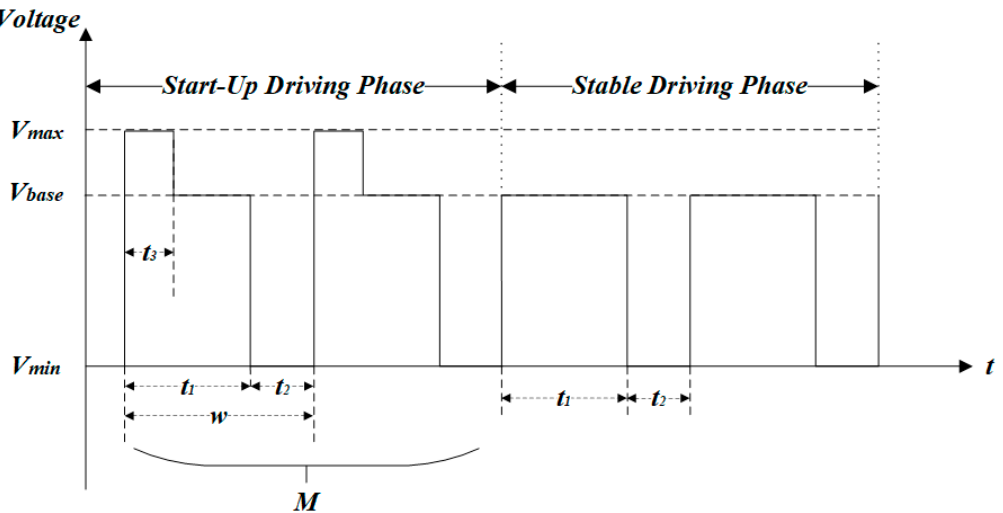
Figure 2. The proposed multi-DC driving waveform.